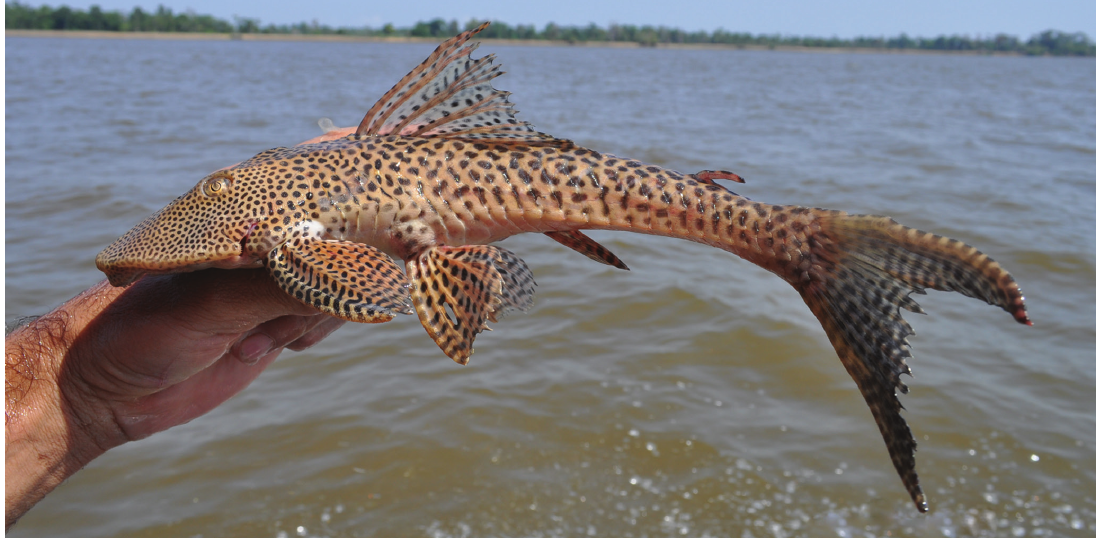
Fig. 3. Lateral view of Aphanotorulus emarginatus , NUP 17748, 257.3 mm SL, Brazil, Amazonas State, Parintins Municipality, Paraná do Ramos, rio Amazon basin. Photographed alive by Hugmar Pains da